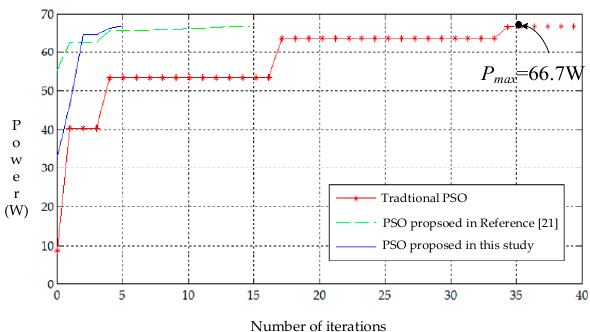
Figure 16. Comparison reuslts of maximum tracking in Case 5 using the traditional PSO, the improved PSO proposed in Refference [21], and the PSO proposed in this study.